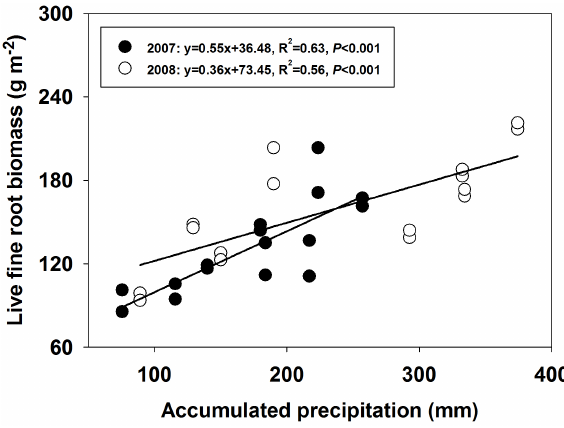
Fig. 5. The relationship between live fine root biomass and accumu- lated precipitation in 2007 (solid circles) and 2008 (open